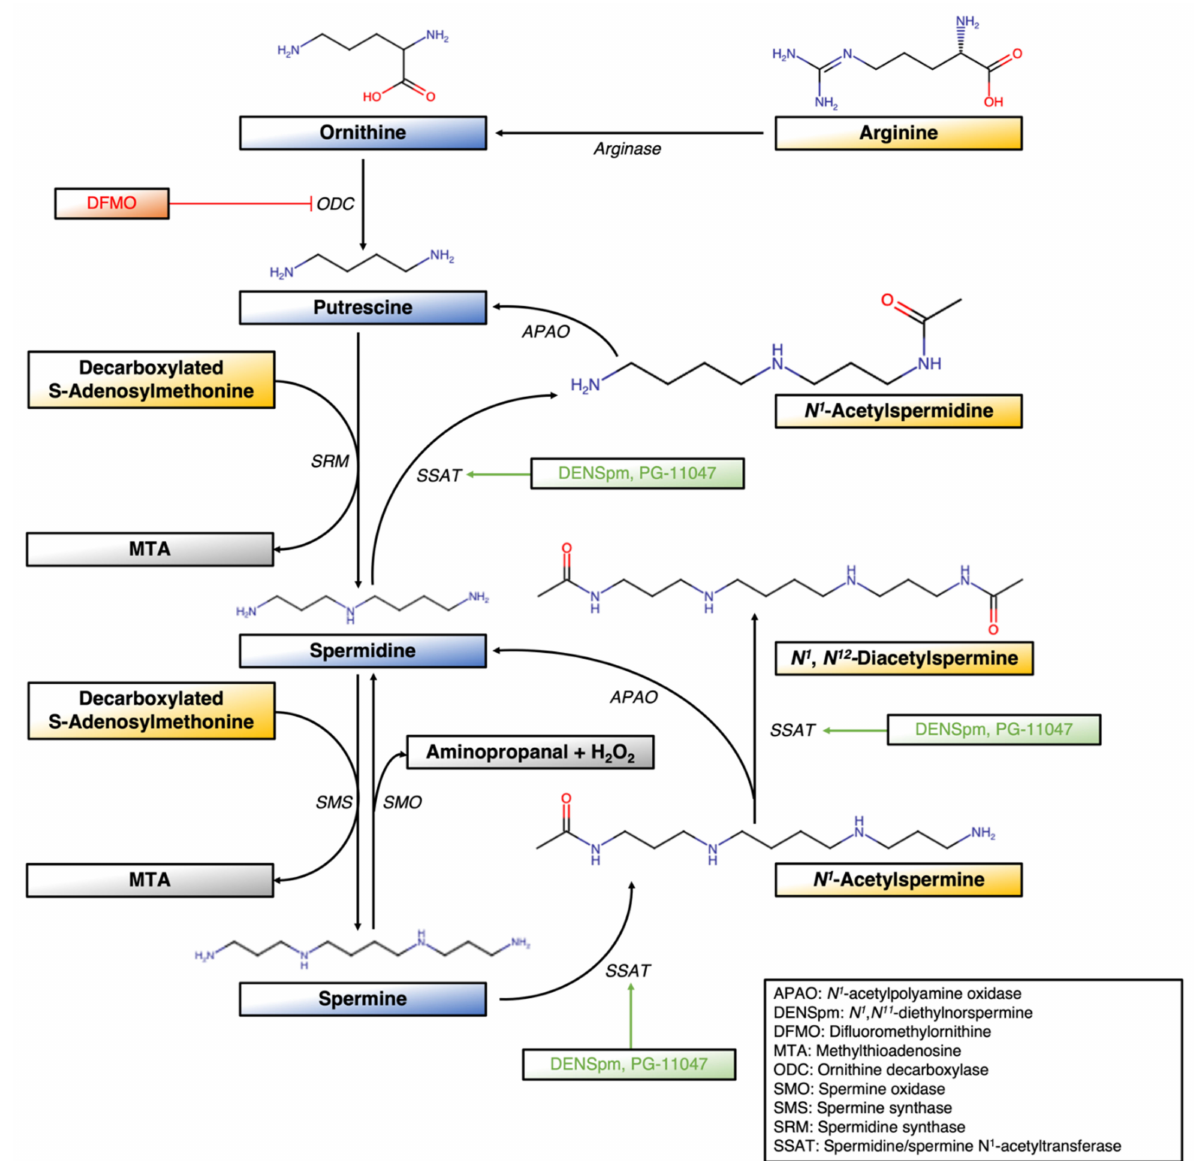
Figure 1. Schematic of polyamine metabolism and related polyamine analog interactions in the pathway. DMFO inhibits ODC whilst DENSpm and PG-11047 induce SSAT